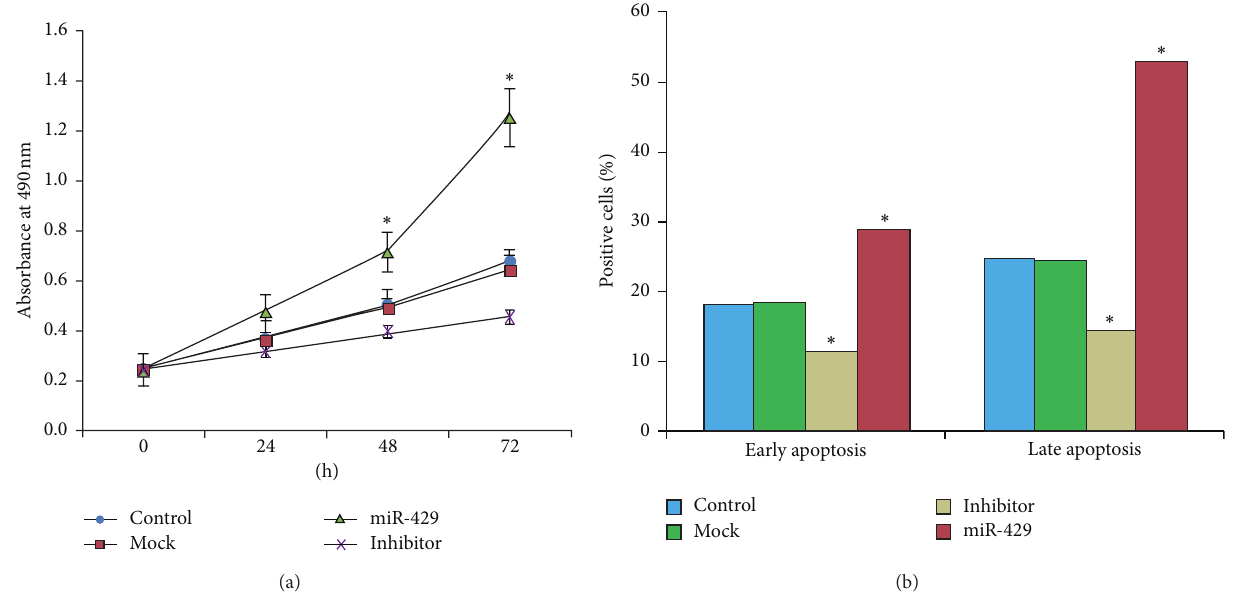
Figure 4: MiR-429 expression modified the proliferation and the apoptosis of HCC cancer cells. According to the types of mimics transfected, cell lines were divided into four groups: control group (Control, by null mimics), mock group (Mock, by mock mimics) miR-429 group (miR-429, by mature miR-429 mimics), and inhibitor group (Inhibitor, by inhibitor of mature miR-429). (a) Association between miR- 429 expression and cancer cell proliferation was elucidated using the 3-(4,5-dimethylthiazol-2-yl)-2,5-diphenyltetrazolium bromide (MTT) reduction assays. (b) Relationship between miR-429 expression and cancer cell apoptosis was evaluated by flow cytometry technique. Data were analyzed using one-way ANOVA with Bonferroni corrections. ∗ 𝑃 < 0.05